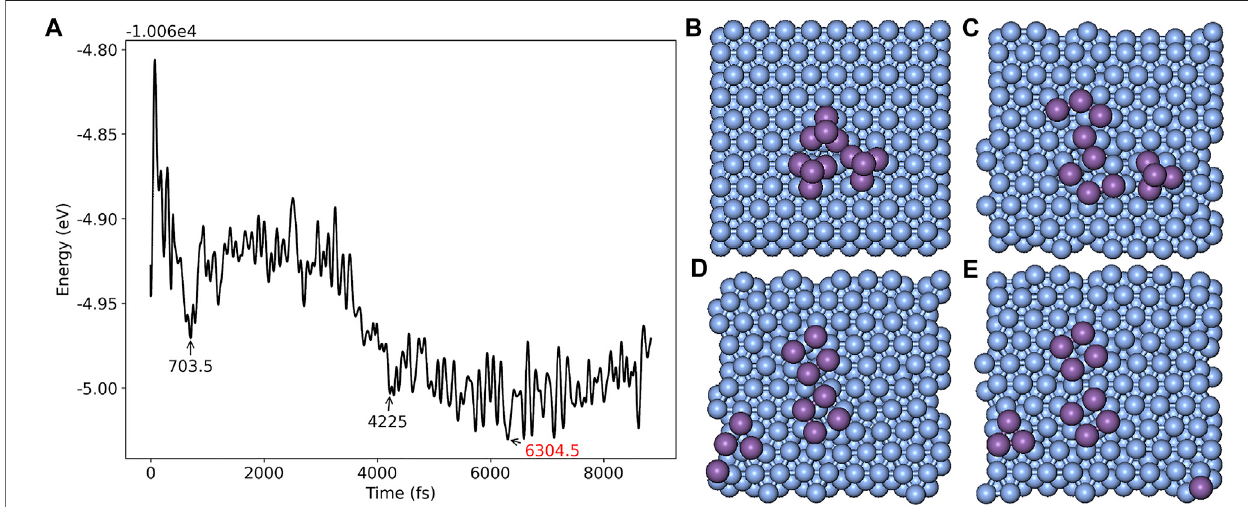
FIGURE6|(A) TotalenergyofthesystemasafunctionoftimefromtheAIMDsimulationforthreeSb 4 clustersonpureAg(111)surfaceat300Kandzeropressure; Systemstructuresat (B) 0fs(initial con fi guration), (C) 703.5fs(two ofSb 4 clusterscollapse toplanar con fi guration), (D) 4,225 fs(allthree Sb 4 clusterscollapse toplanar con fi guration), and (E) 6,304.5 fs (the con fi guration with the lowest energy) are listed at right, respectively.